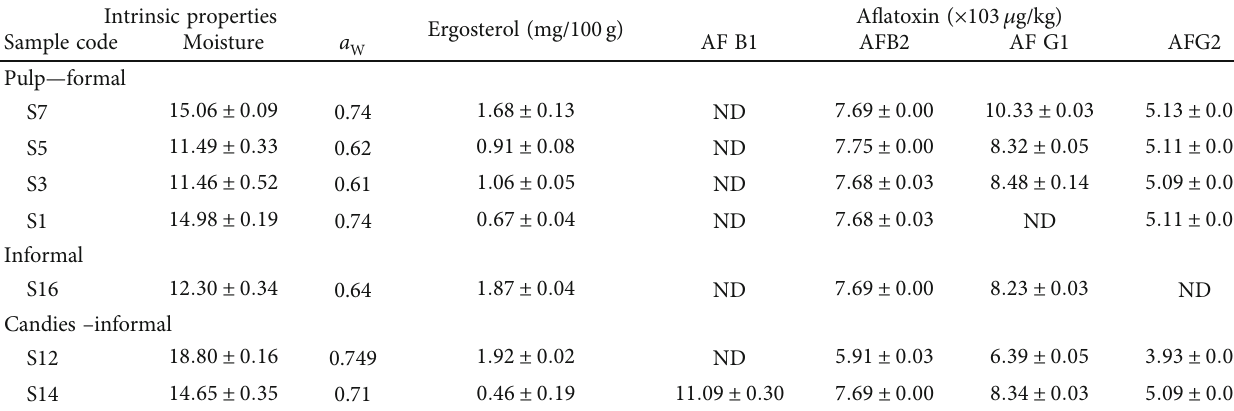
Table 3: Ergosterol and a fl atoxin content ( mean ± SE ) of baobab products.